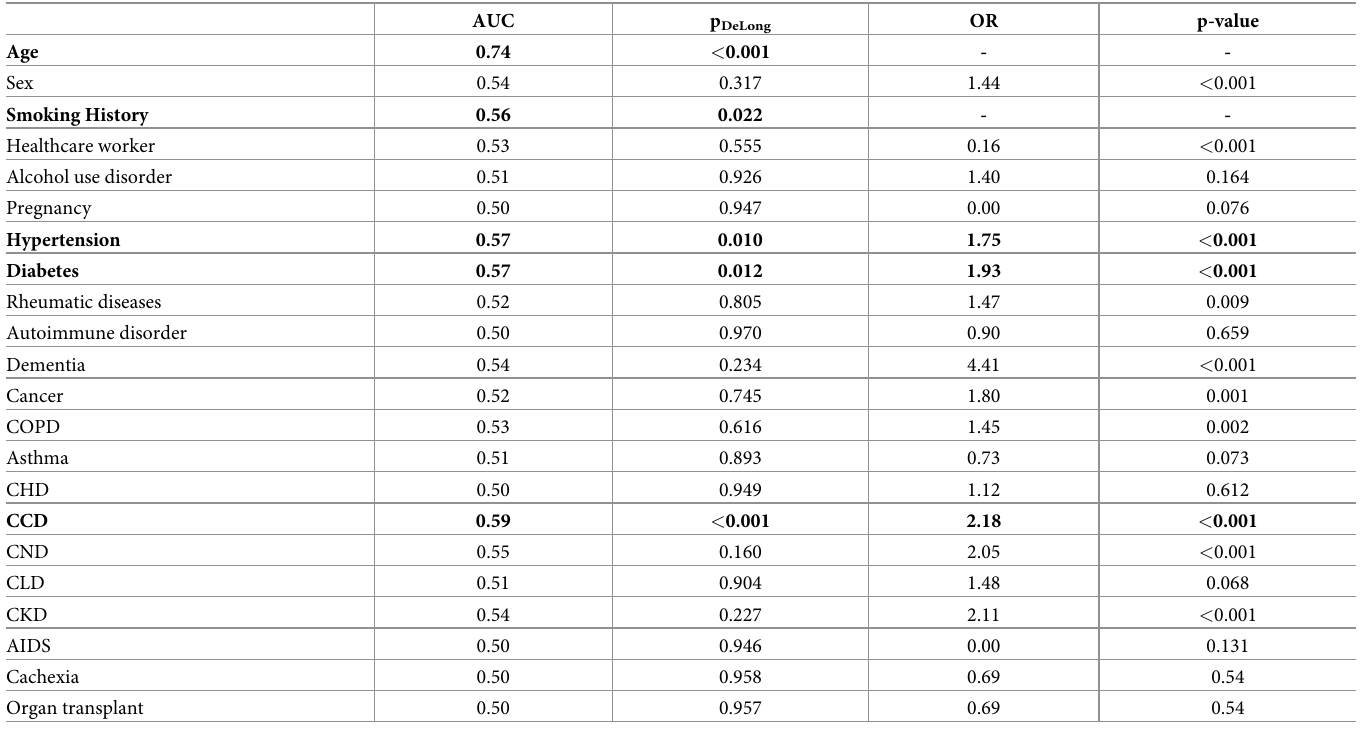
Table 3. Results of univariate feature selection in the training cohort using the novel metric p DeLong .